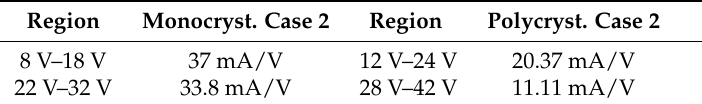
Table 10. Slopes of I–V